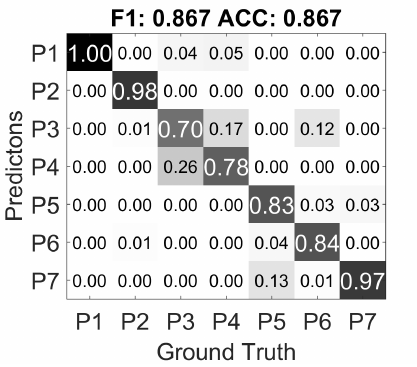
Figure 10. Confusion matrix of the person independent exclusive case of Group